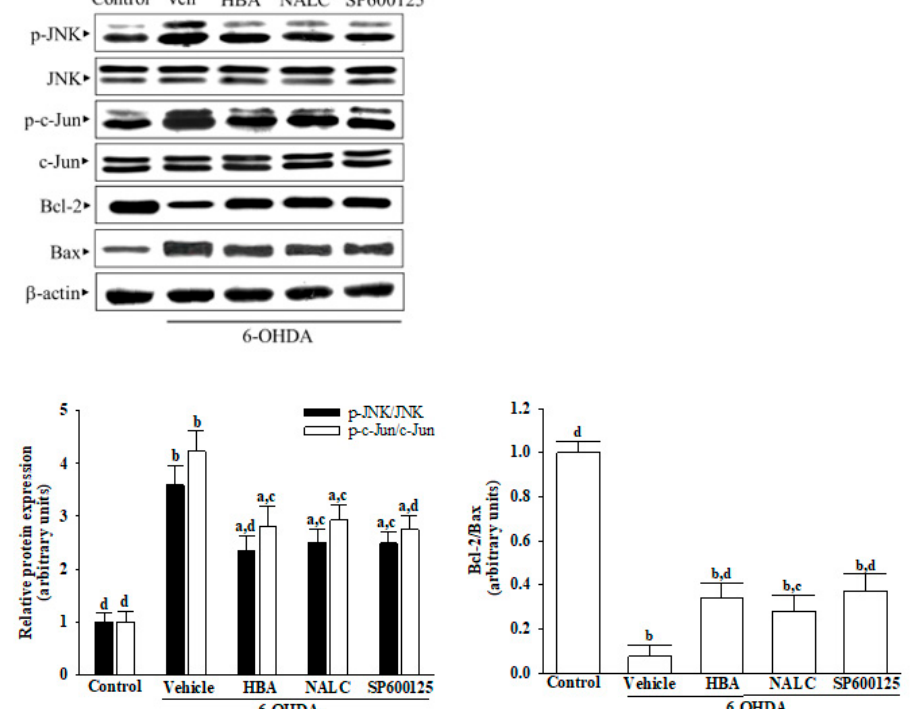
Figure 5. HBA reduces activation of the JNK/c-Jun signal induced by 6-OHDA. SH-SY5Y cells were pretreated with HBA (120 µ mol/L), NALC (1 mmol/L), or SP600125 (10 µ mol/L) for 1 h and then exposed to 6-OHDA (100 µ mol/L) for another 24 h. Photographs representing Western transfer analysis for p-JNK, JNK, p-c-Jun, c-Jun, Bax, and Bcl-2. The ratio between phosphoprotein and total protein was calculated for JNK (p-JNK/JNK) and c-Jun (p-c-Jun/c-Jun). The ratio between the relative intensities of Bcl-2 and Bax (Bcl-2/Bax) has been indicated. The results are shown as the mean ± SD of five independent experiments ( n = 5) performed in triplicate. a p < 0.05 and b p < 0.01 compared to the data from untreated control group (control); c p < 0.05 and d p < 0.01 compared to the data from cells exposed to 6-OHDA with no